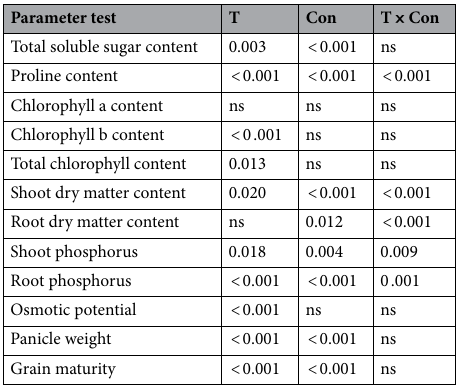
Table 1. Analyses of variance depicting the effect of inoculated treatment (T), two watering conditions (Con), and their interaction on the physiological and biochemical parameters in the 21-day water limitation and the production in harvesting state. The numbers indicate significant difference, and ns represent non-significant